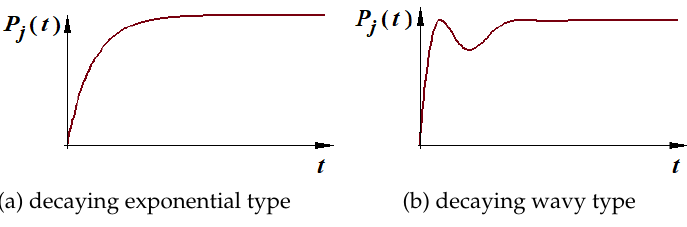
Figure 2. Types of transient